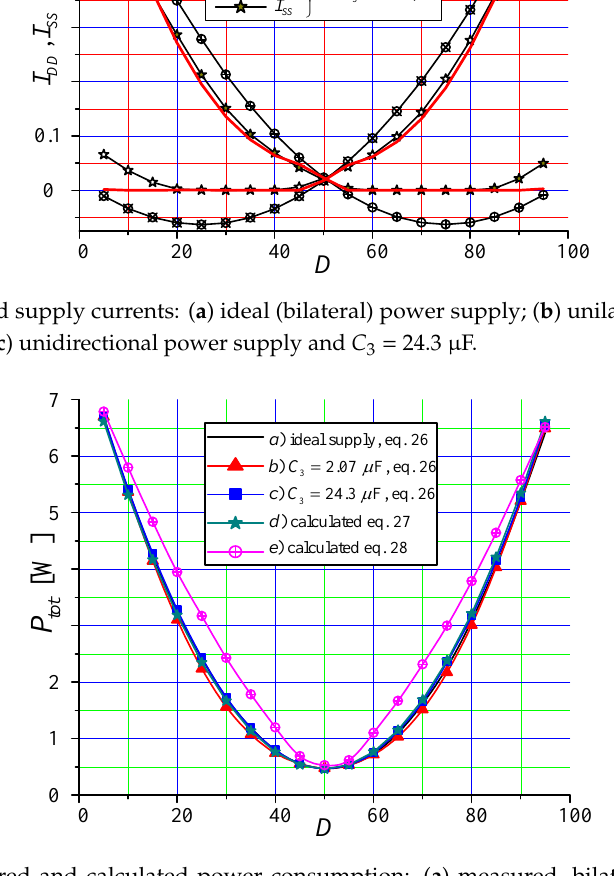
Figure 9. Measured supply currents: ( a ) ideal (bilateral) power supply; ( b ) unilateral power supply and C 3 = 2.07 μF; ( c ) unidirectional power supply and C 3 = 24.3 μF .